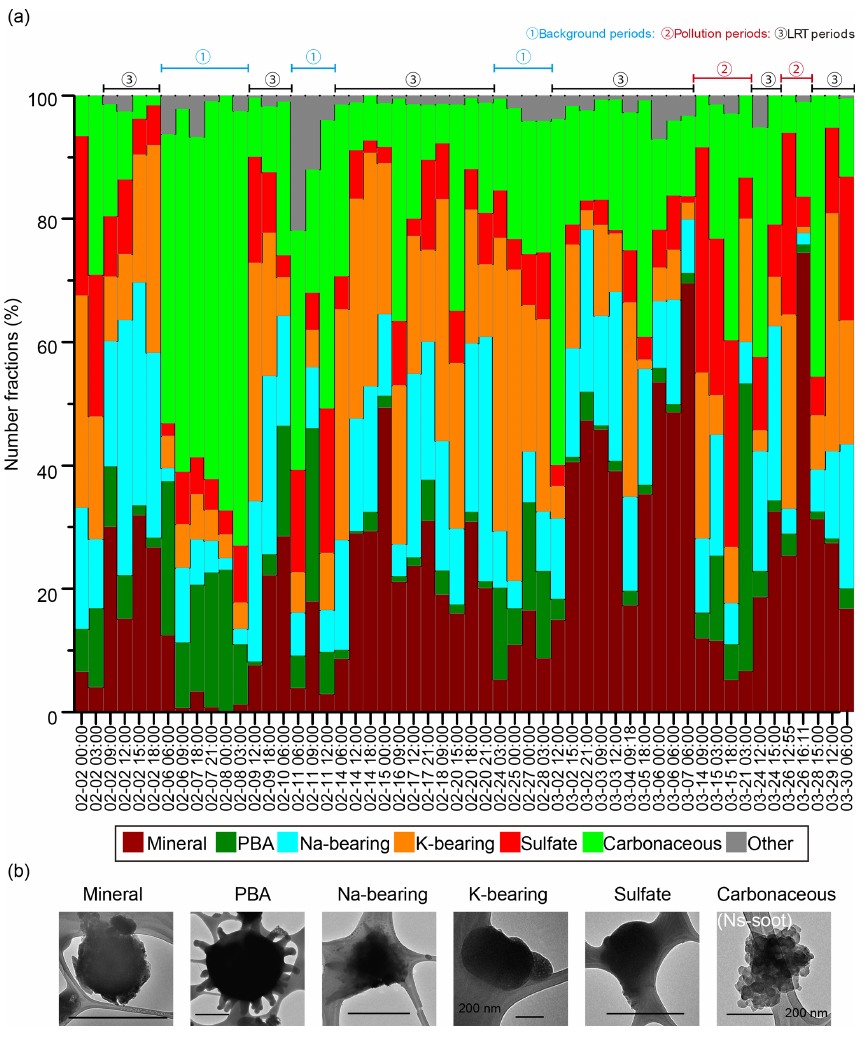
Figure 1. Number fractions of each aerosol particle type for all analyzed samples (a) and the representative TEM images of each particle type (b) . The scale bars for mineral, PBA, Na-bearing, and sulfate particles are 1µm, and those for K-bearing and carbonaceous particles are 200nm. Compositions and low-magnification images of these particles are shown in Fig. S2 (mineral), Fig. S5 (PBA), Fig. 11 (Na-bearing), Fig. S7 (K-bearing), Fig. S8 (sulfate), and Fig. S7 (carbonaceous). Samples were divided into LRT and other periods (bars in panel a ). Other periods were further divided into pollution periods (14, 15, and 26 March 2014) and background periods (all other periods except the pollution periods and 2 February 2014) based on the classifications of de Sá et al. (2018). Samples collected on 2 February were outside of the measurement period of de Sá et al.